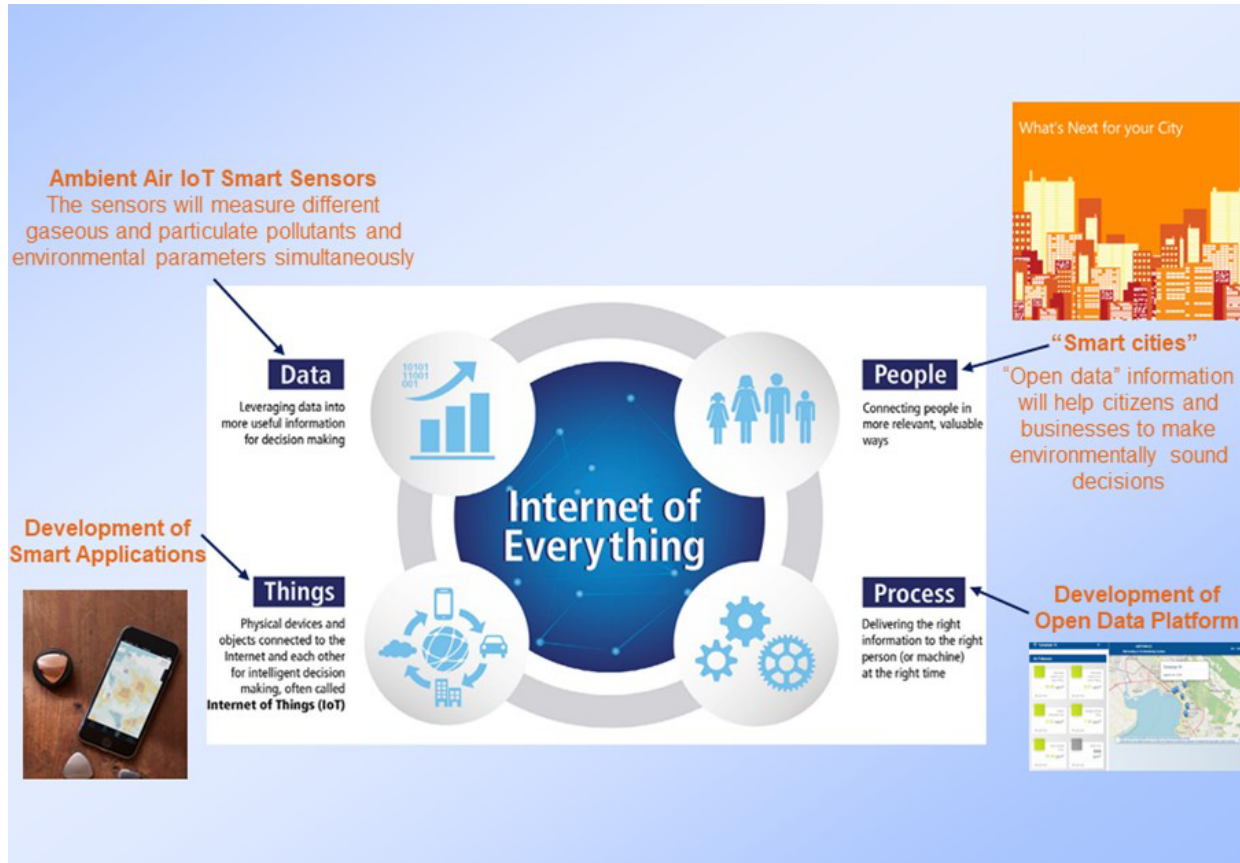
Figure 7. Exploitation of Internet of Everything technology with things, sensor data, open data platforms, and actions of